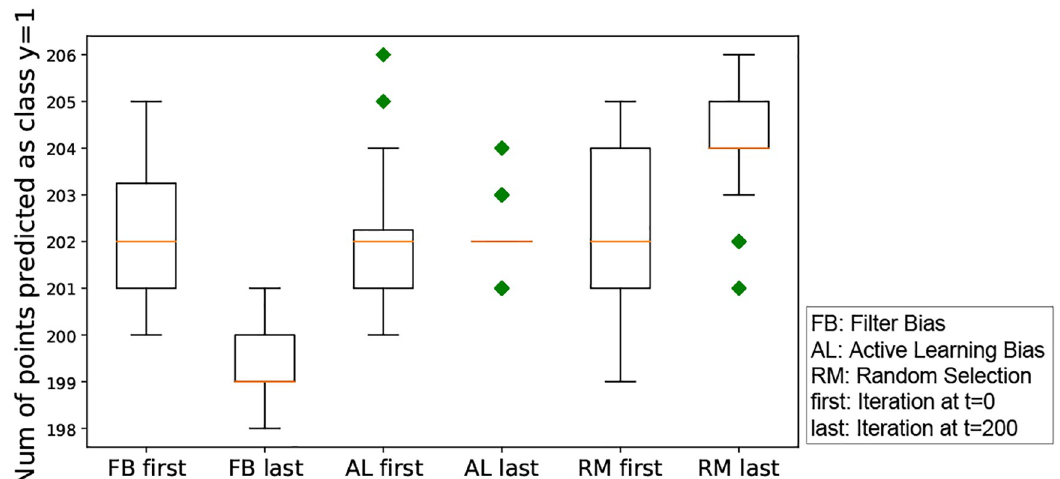
Fig 11. The box-plots showing the distribution of the number of points that are predicted to be in class y = 1 in the first and last iterations of the iterated learning for three iterated algorithmic biases with human action probability ratio 10:1. Filter bias significantly decreases the number of points predicted to be in class y = 1. On the other hand, random selection significantly increases the number of points predicted to be in class y = 1. Active learning has no such significant effect.